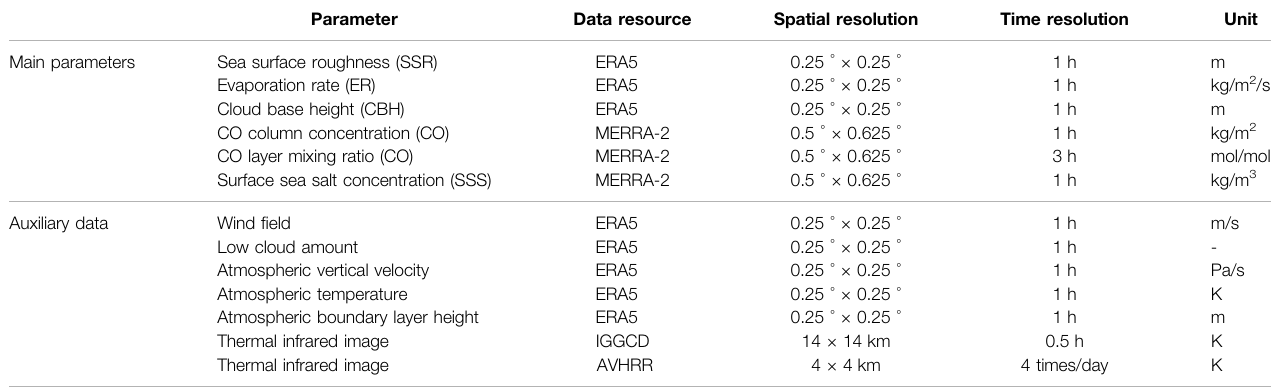
TABLE 1 | The information of main parameters and auxiliary data.